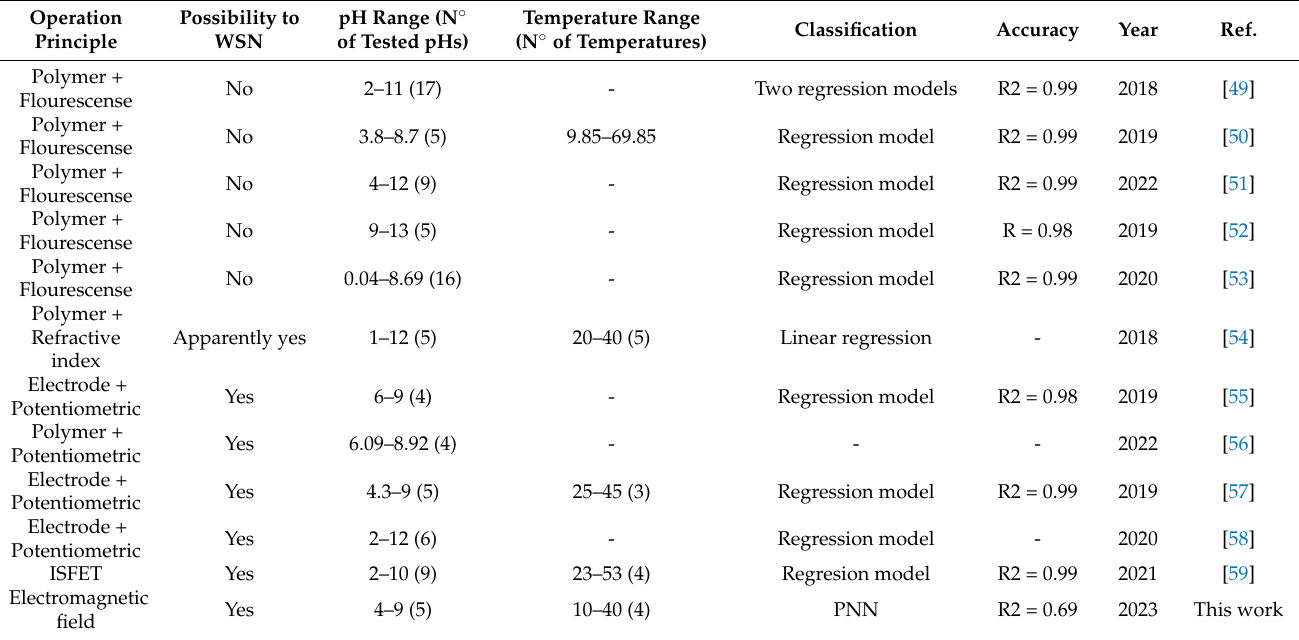
Table 20. Summary of recent pH